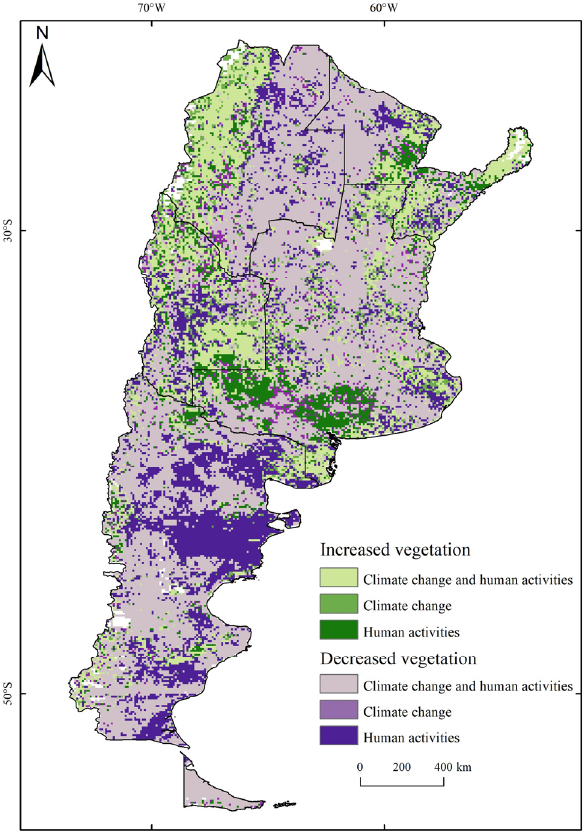
Figure 8. Driving forces of vegetation change in Argentina from 1982 to 2015.